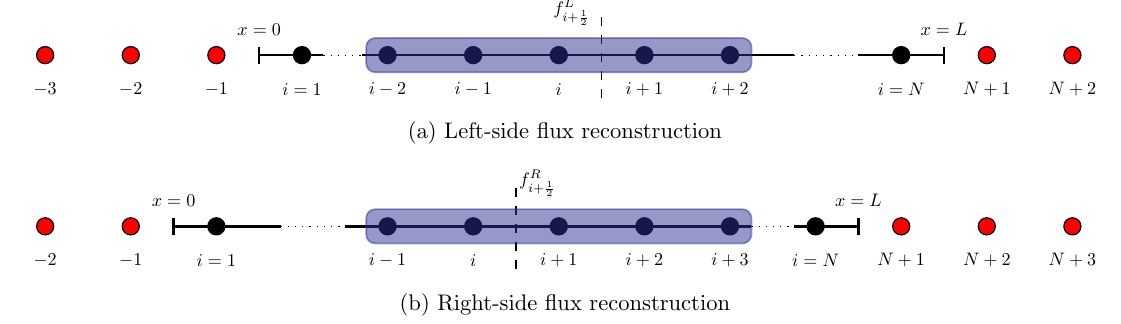
Figure 10. Finite difference grid for one-dimensional problems where the the solution is stored at the center of the cells. The flux is also computed at left and right boundary. The stencil required for reconstruction of left and right side flux is highlighted with blue rectangle. Ghost points are shown by red